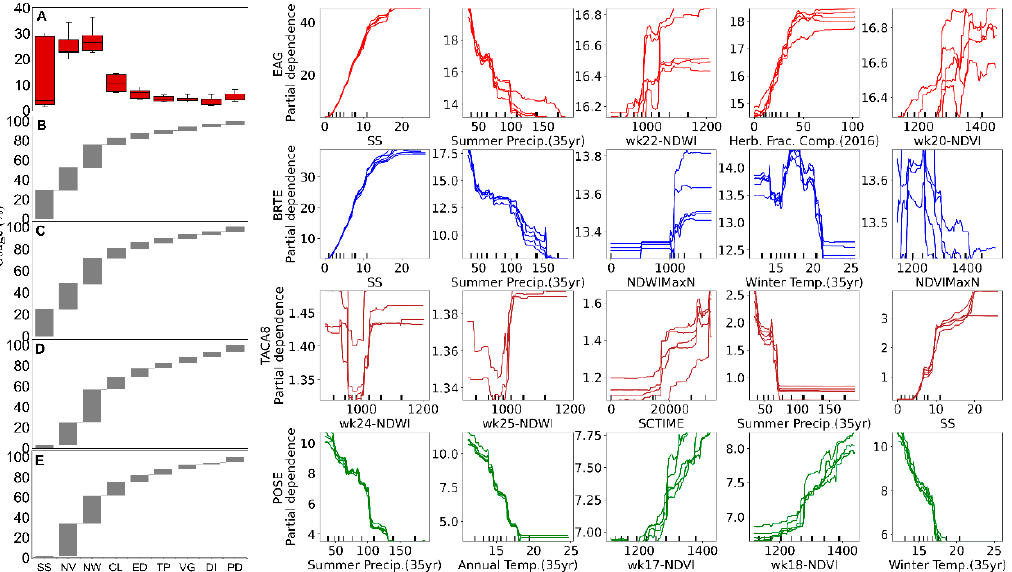
Figure 6. ( Left ) Predictor variable usage and ( right ) partial dependence plots (PDP) across all five iterations of boosted regression tree models. The plots are arranged in order of decreasing importance from left to right. ( A ) Box and whisker plots showing the variance of importance between five models. Whiskers show minimum and maximum values while the boxes show the 25th and 75th percentile. The line indicates median variable usage. Accumulative average of predictor variable importance of five models for EAG ( B ), cheatgrass ( C ), medusahead ( D ), and Sandberg bluegrass ( E ). SS = seed source, NV = weekly NDVIs, NW = weekly NDWIs, CL = climatic, ED = edaphic, TP= topographic, VG = vegetation, DI = disturbance, and PD = pheno-derivatives (see Section 2.3). The hash marks at the base of each PDP represent the deciles of the predictor variable distribution. EAG = combination of 16 exotic annual grasses, BRTE = cheatgrass, TACA8 = medusahead, and POSE = Sandberg bluegrass.